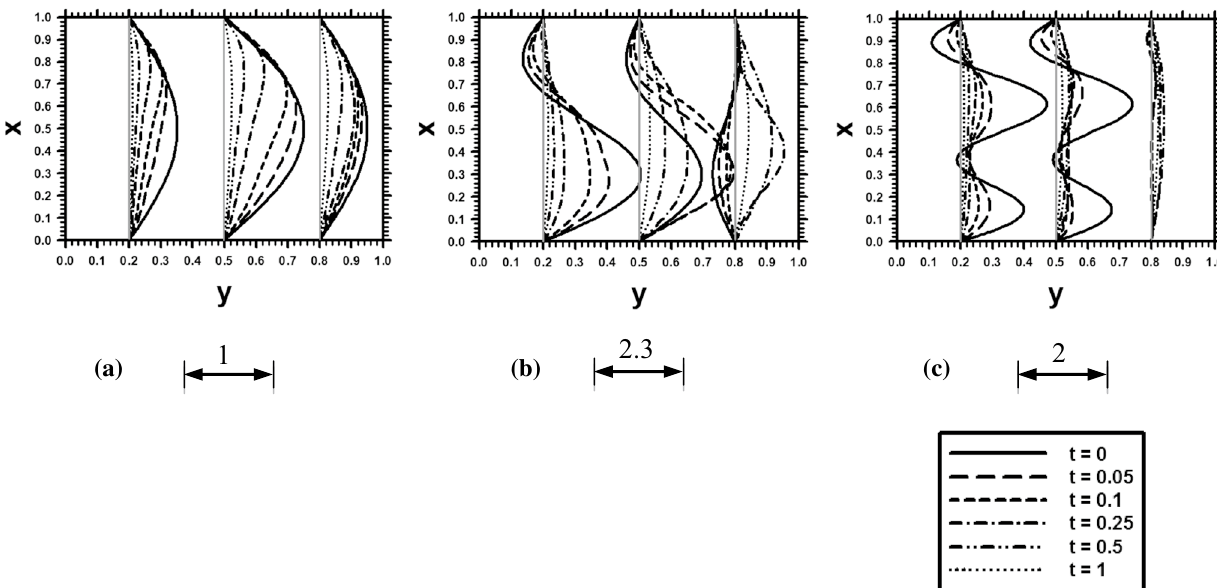
Fig. 2 A sample of distribution of the velocity of the a longitudinal ( u ), b depth ( v ) and c transverse ( w ) along the length and for passing plate 𝜐 through the middle of the width ( =